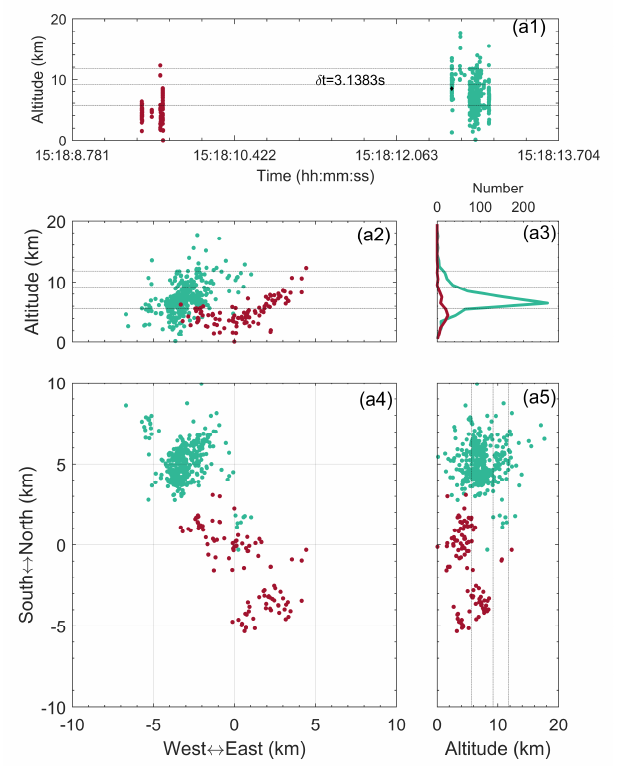
Figure 9. TLF named T20190702152112 (in red color) and NLF (in green color) occurring within 5 s after the TLF and propagating the channels into 5 km radius of the flash-triggered position. ( a1 – a5 ) Subplot information is same as in Figure